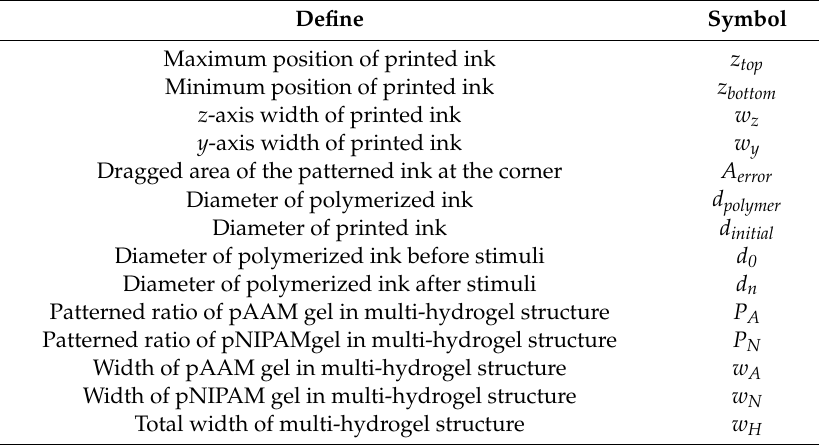
Table 3. Glossary of